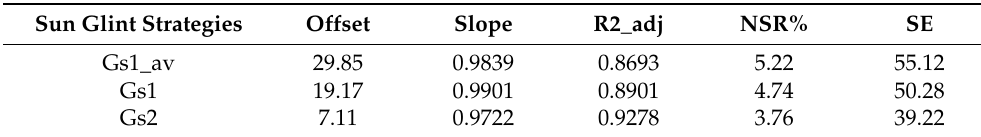
Figure 6. The comparison for accuracy for three sun glint strategies listed in Table 5 using AERONET aerosol data. Table 7. Statistical results for three sun glint strategies (Gs1_av, Gs1 and Gs2) using the AERONET aerosol data source. Offset and SE are 10,000 x reflectance, NSR is %